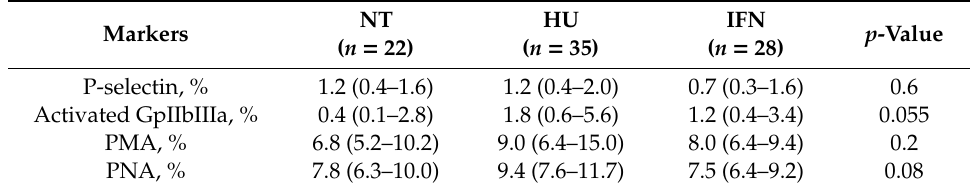
Table 3. Markers of in vivo platelet activation according to cytoreductive treatment group.